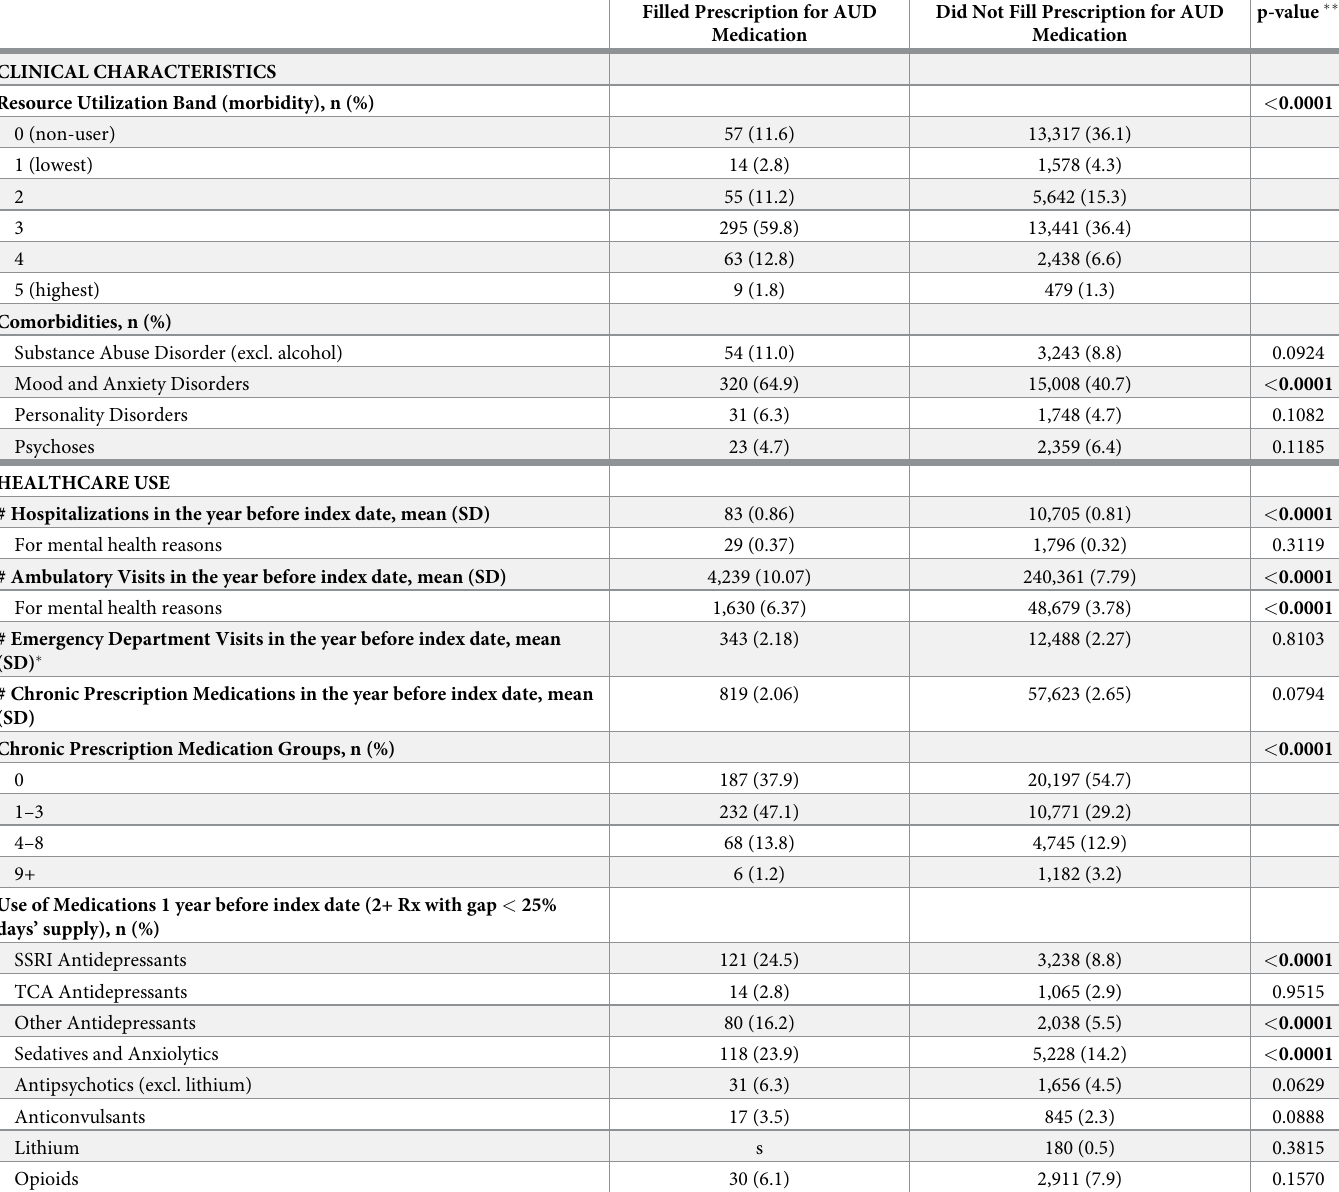
Table 2. Clinical characteristics and healthcare use of Manitobans with alcohol use disorder.